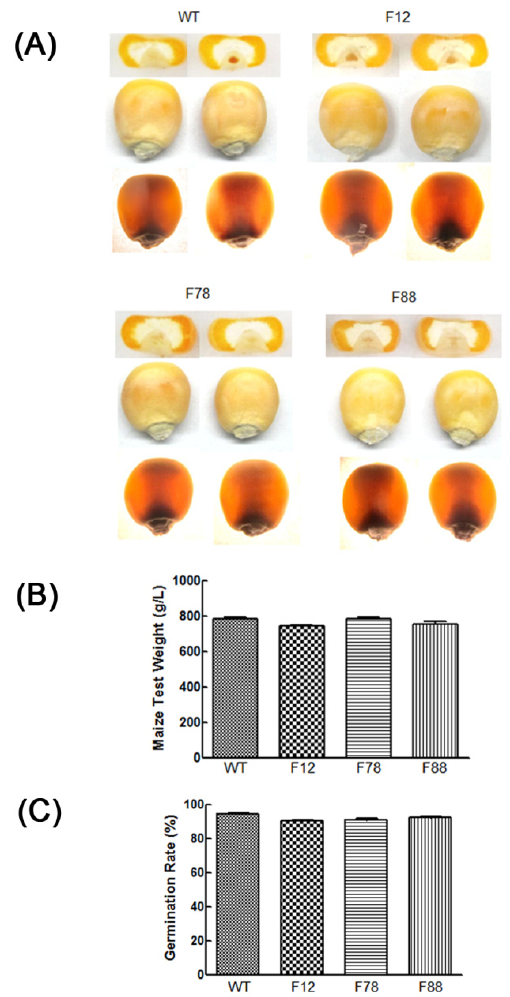
Figure 5. Kernel appearance and maize test weight of T seeds in three transgenic lines. 3 ( A ) Kernel appearance. Three kernels were selected at random from WT and three transgenic lines, and their appearances were observed with an incandescent (top and middle) and transmitted (bottom) light; ( B ) Maize test weight; ( C ) Germination rate. A Student’s t- test was used to evaluate the differences between each transgenic line and